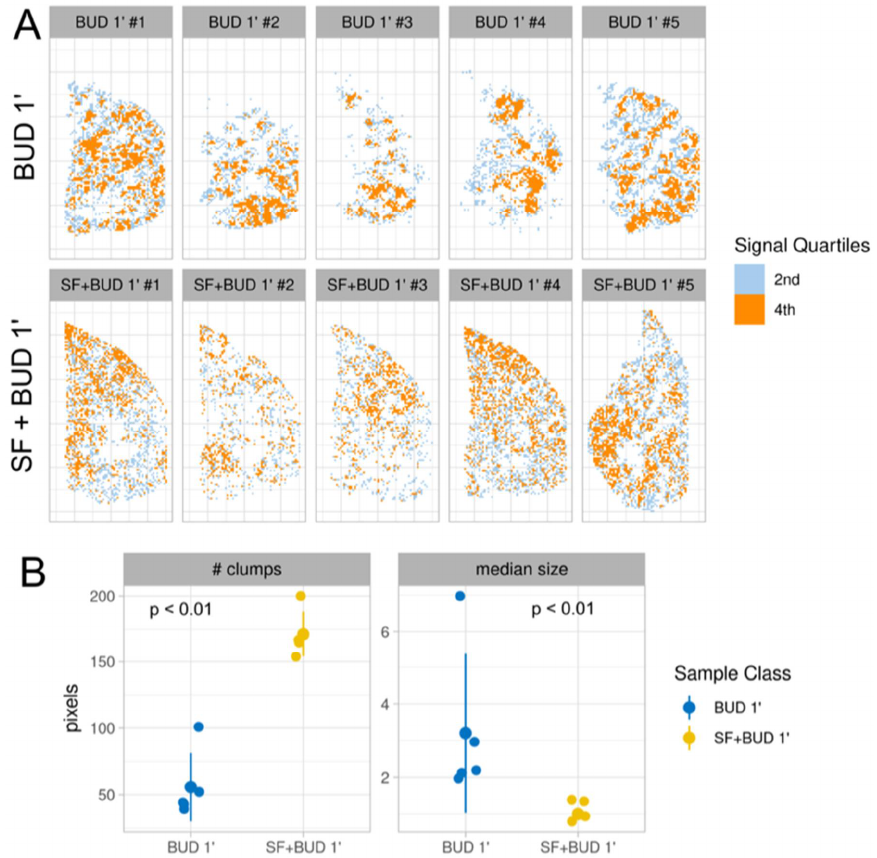
Figure 4. Statistical analysis of budesonide distribution. ( A ) 2D ion intensity images displaying the distribution of the 2nd (grey) and 4th (orange) quartiles of the budesonide intensity. The images were obtained from distal right lung samples from premature lambs that were ventilated for just 1 min after either receiving intratracheal budesonide (0.25 mg/kg, top row, BUD 1 min) or budesonide (0.25 mg/kg) combined with surfactant (200 mg/kg, bottom row, SF+BUD 1 min). ( B ) Comparison of the number of clumps quantified in the ion intensity images and their median size. * p < 0.01, Wilcoxon rank sum exact test .